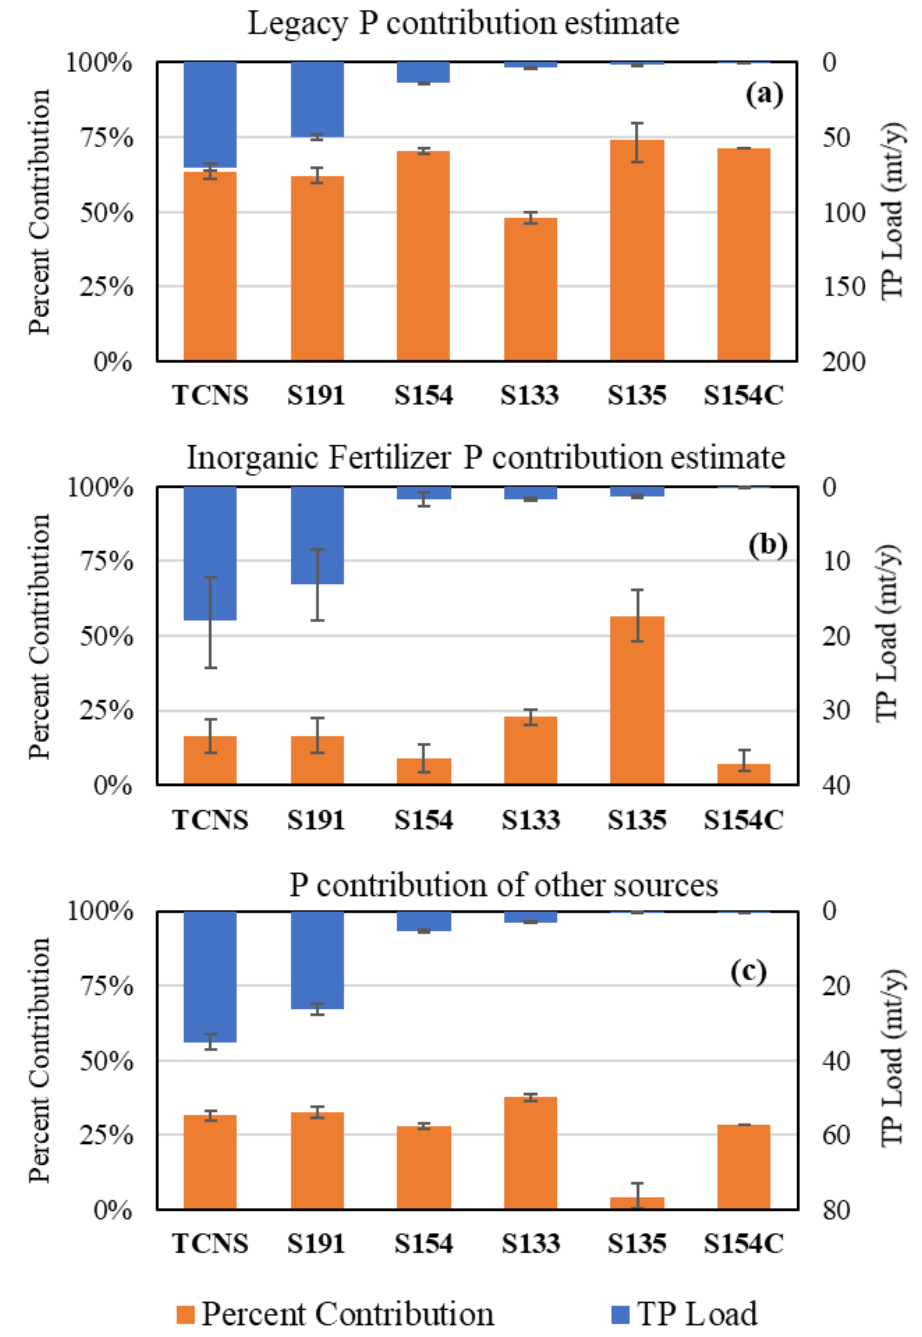
Figure 6. Relative contributions of ( a ) legacy P, ( b ) inorganic fertilizer, and ( c ) all other P sources to the total phosphorus loads. The error bars indicate the minimum to maximum range.